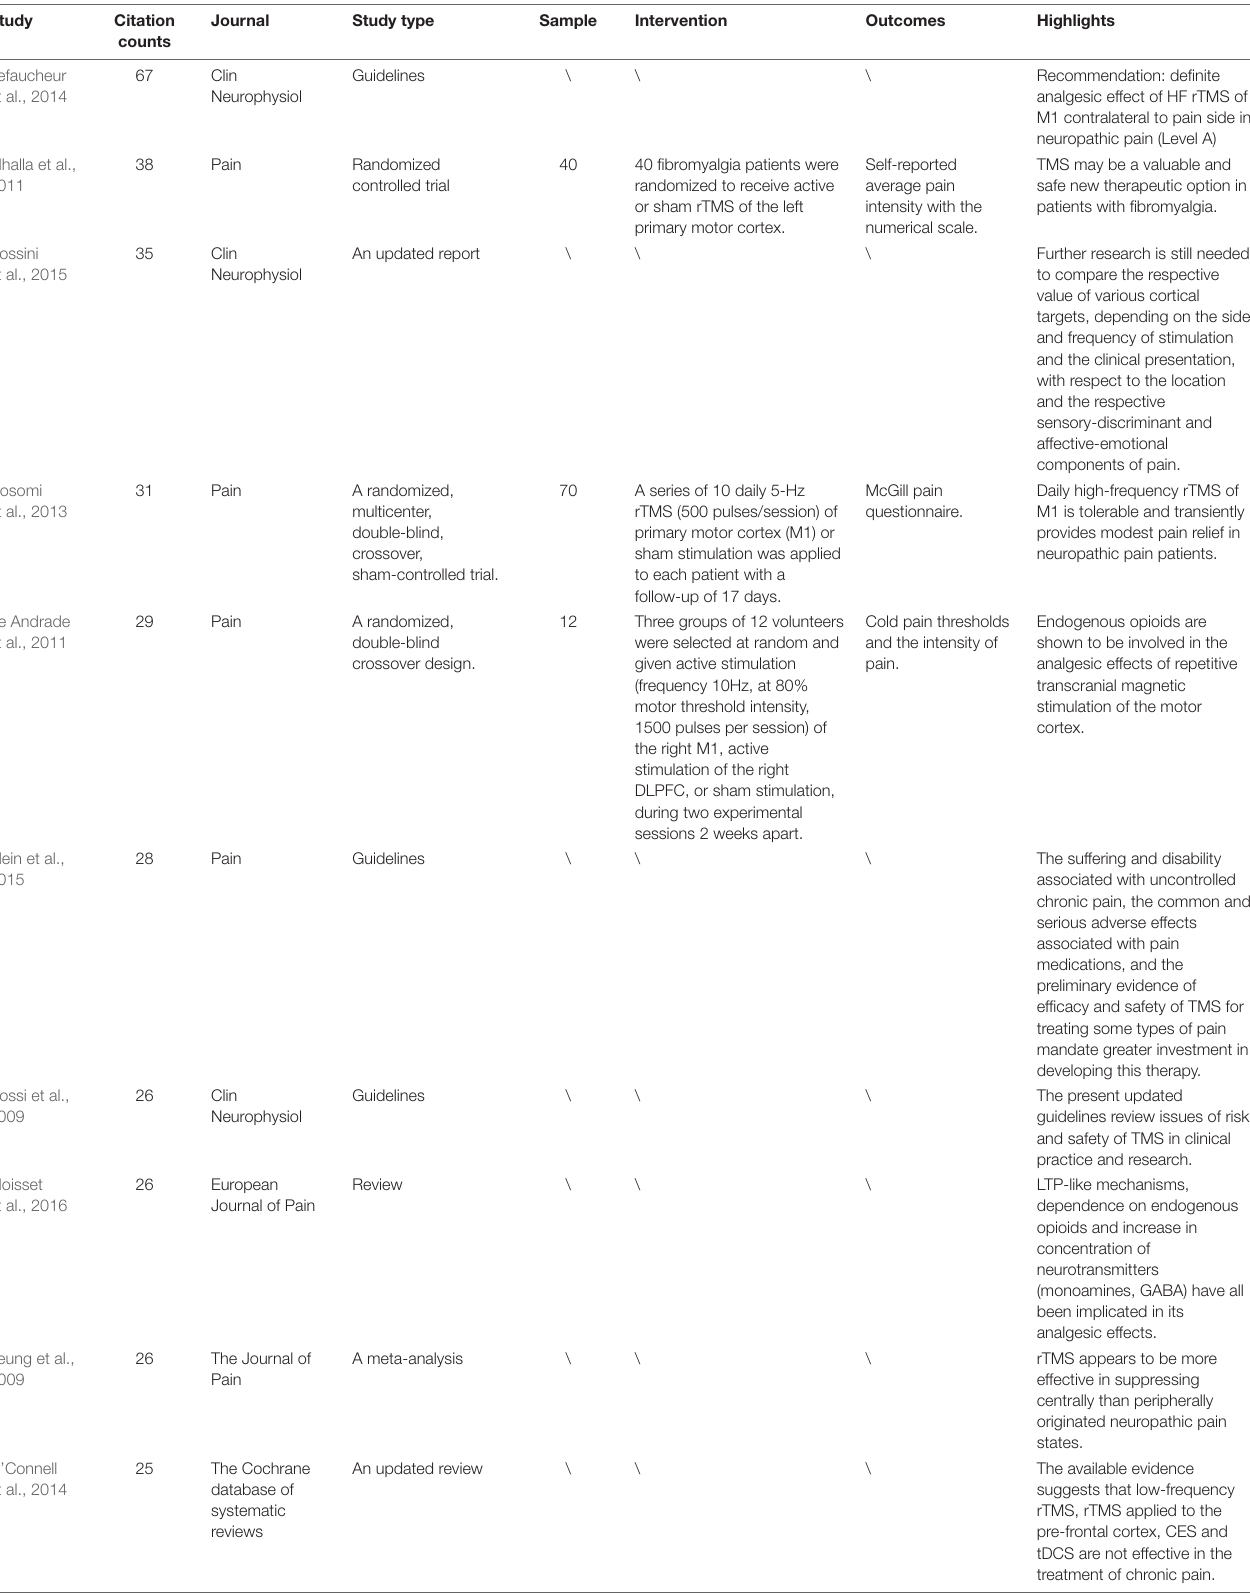
TABLE 1 | Ten representative studies of transcranial magnetic stimulation (TMS) in pain research among the cited references of the included 440